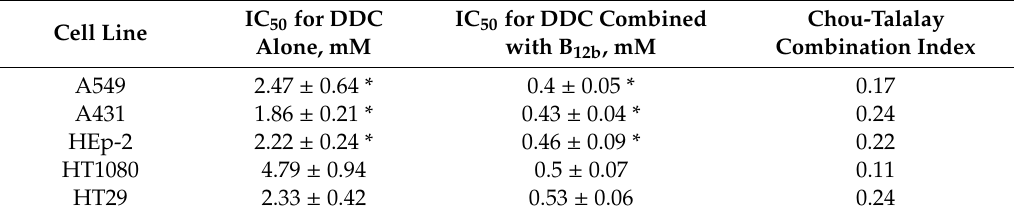
Table 1. IC 50 values for DDC used alone and in combination with 25 µ M B 12b , and CI for di ff